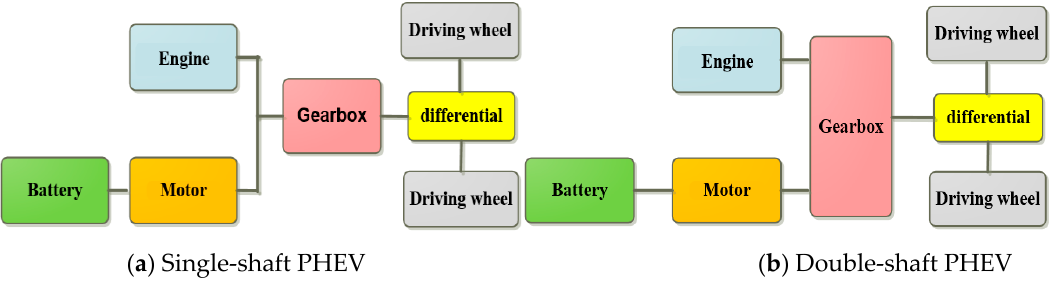
Figure 4. Schematic diagram of powertrain of PHEVs.